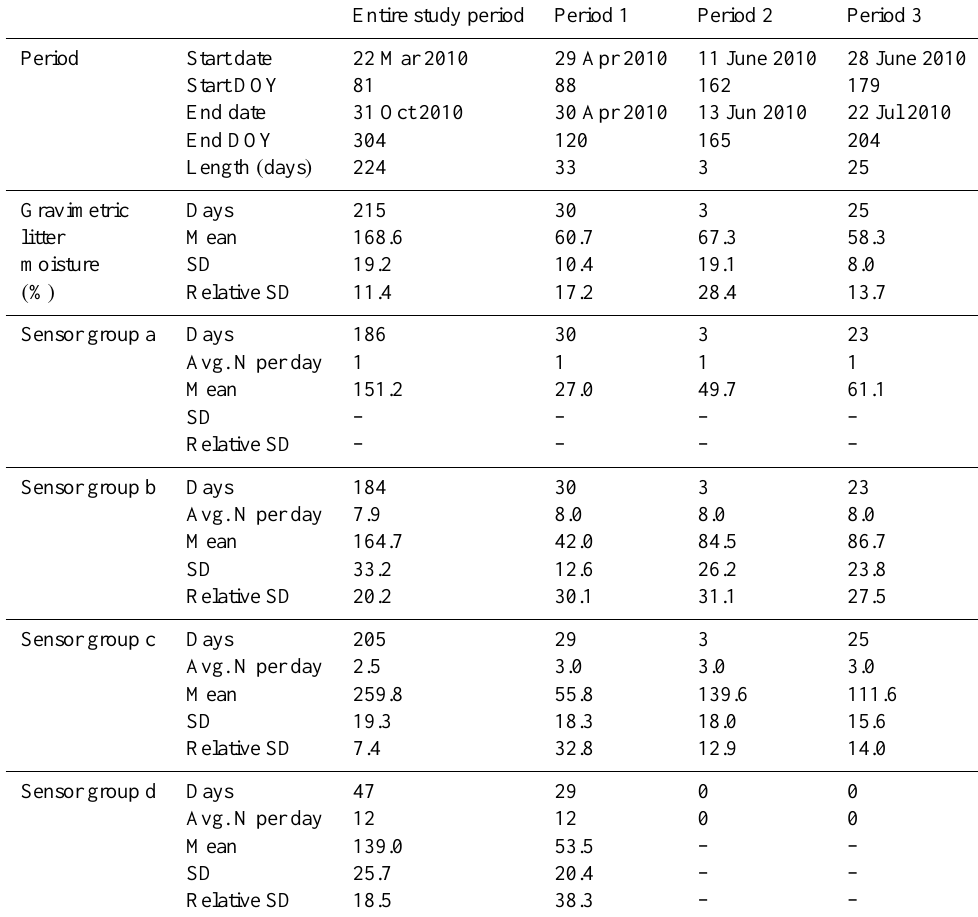
Table 1. Data availability and basic statistics for the entire study period and the three periods defined in Sect. 3.2. Note that on a given day, not all sensors of each group may have been operational due to equipment